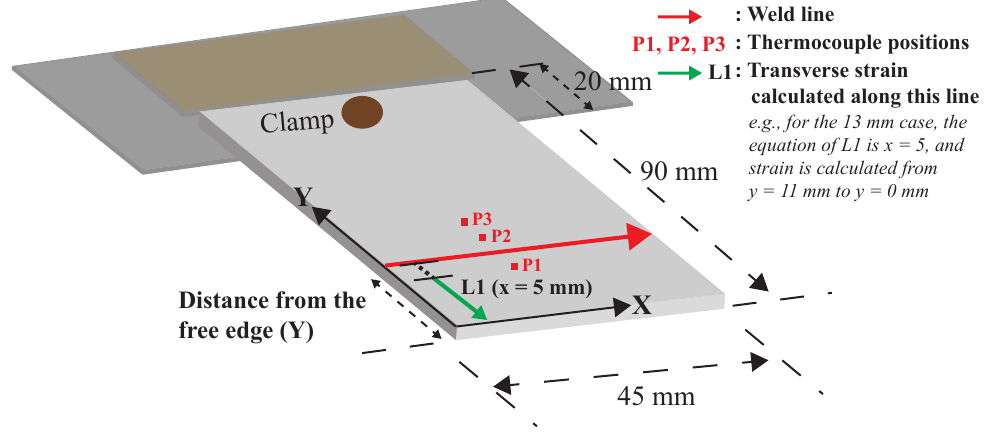
Figure 3. Schematic of the hot cracking test arrangement. Table 1. Composition of the Transformation-Induced Plasticity (TRIP) steel used in this work (in wt. %). Elements, wt. %